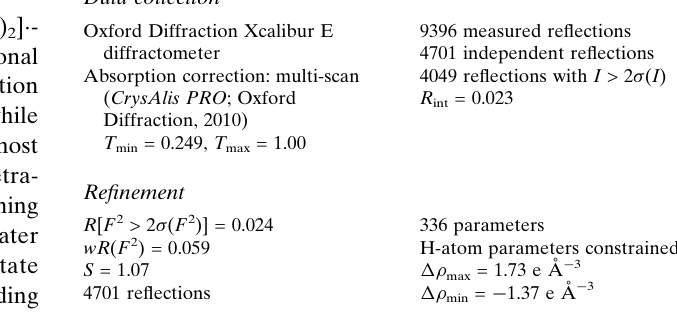
Oxford Diffraction Xcalibur E diffractometer Absorption correction: multi-scan ( CrysAlis PRO ; Oxford Diffraction, 2010) T min = 0.249, T max = 1.00